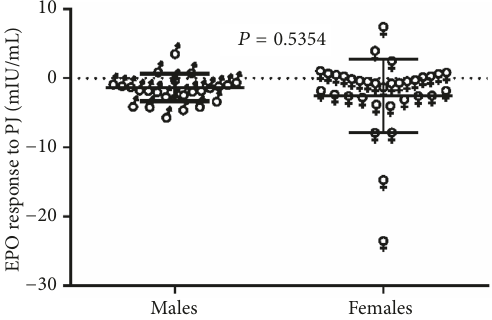
Figure 2: Correlation between EPO response to PJ and FSG concentrations in patients with T2D (n = 59).